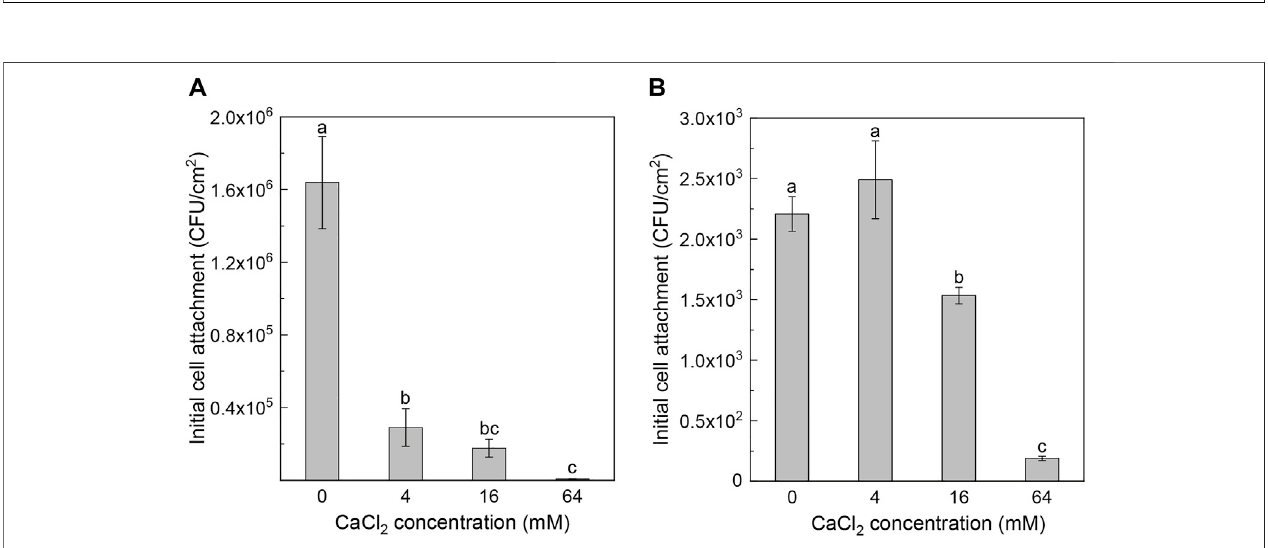
FIGURE 2 | Digital photos of bio fi lms formed in 12-well microtiter plates by Pseudomonas sp. ZX01 (A) and Arthrobacter sp. ZX07 (B) when adding different concentrations of CaCl 2 into the medium. Cells in bio fi lms were stained using 0.1% crystal violet.